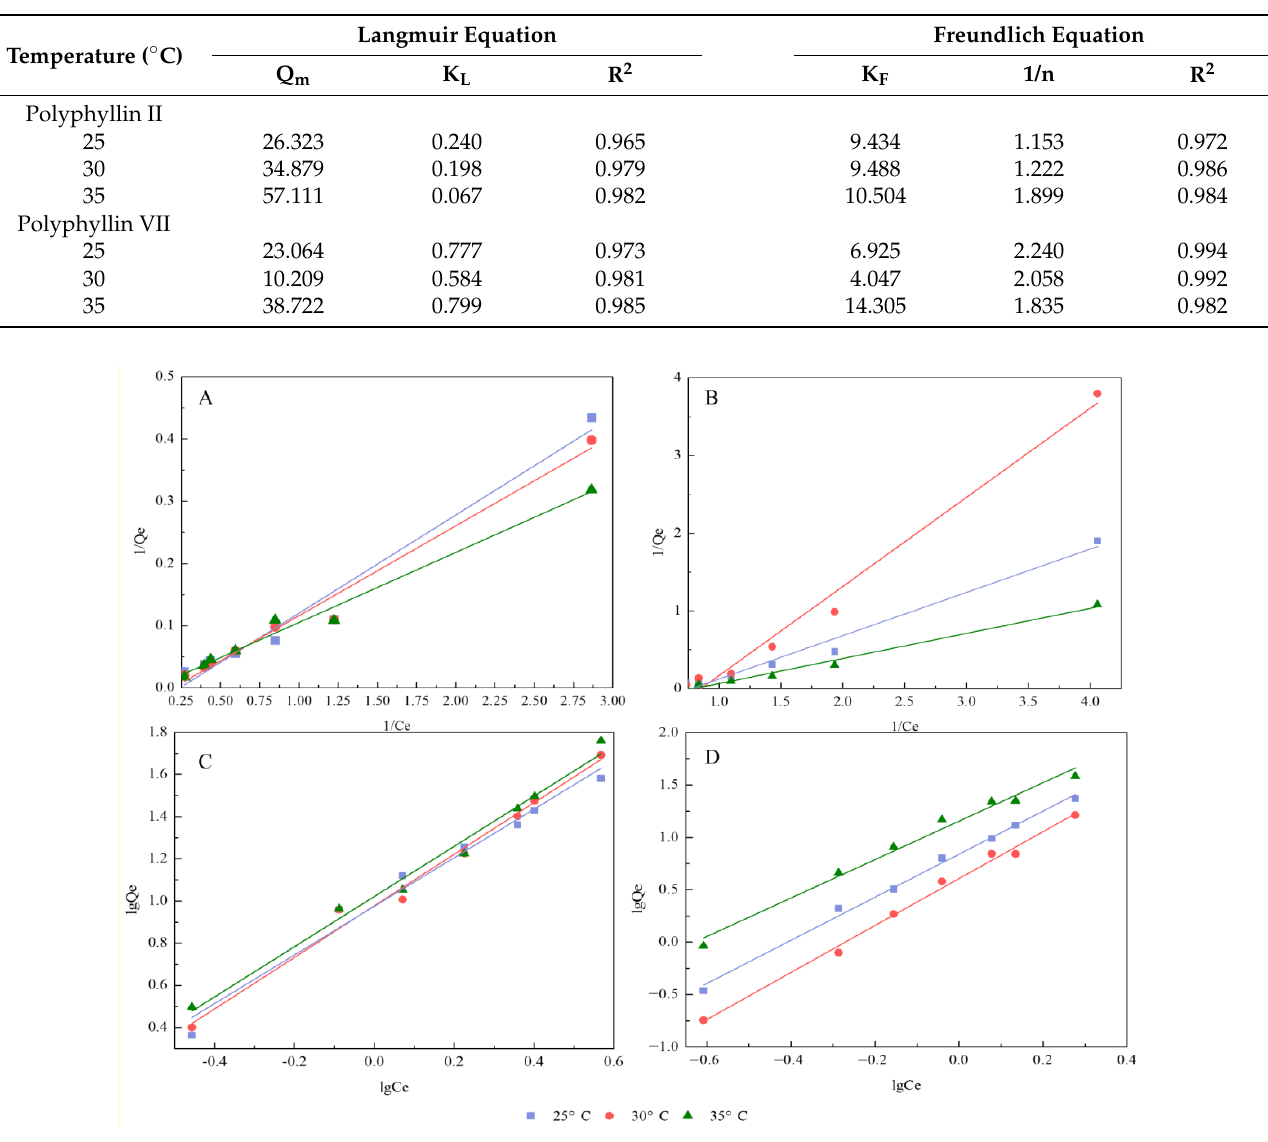
Table 5. Correlation coefficients of the Langmuir and Freundlich equations.